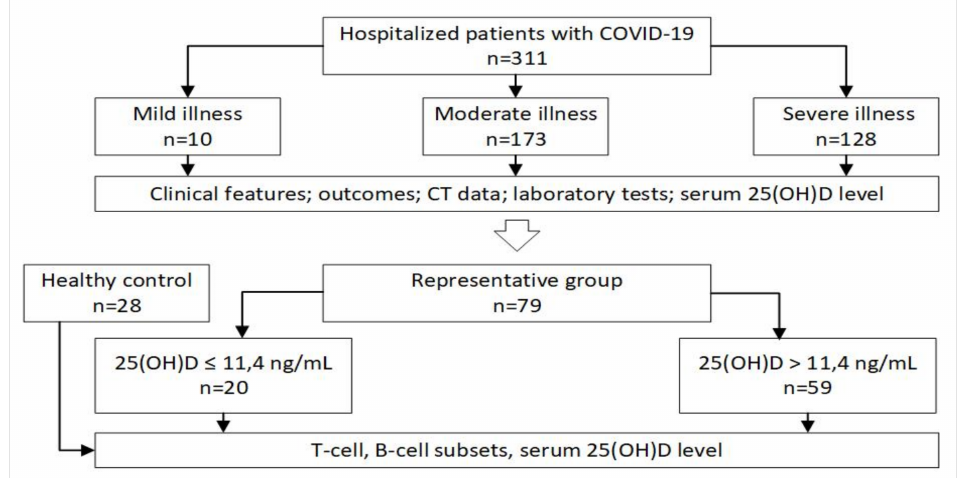
Figure 2. Study design: 25(OH)D—25-hydroxyvitamin D; CD—cluster of differentiation.